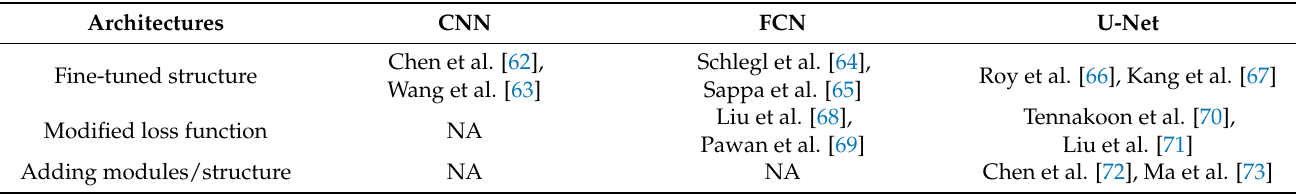
Table 2. Typical deep learning method for cysts/fluid segmentation.